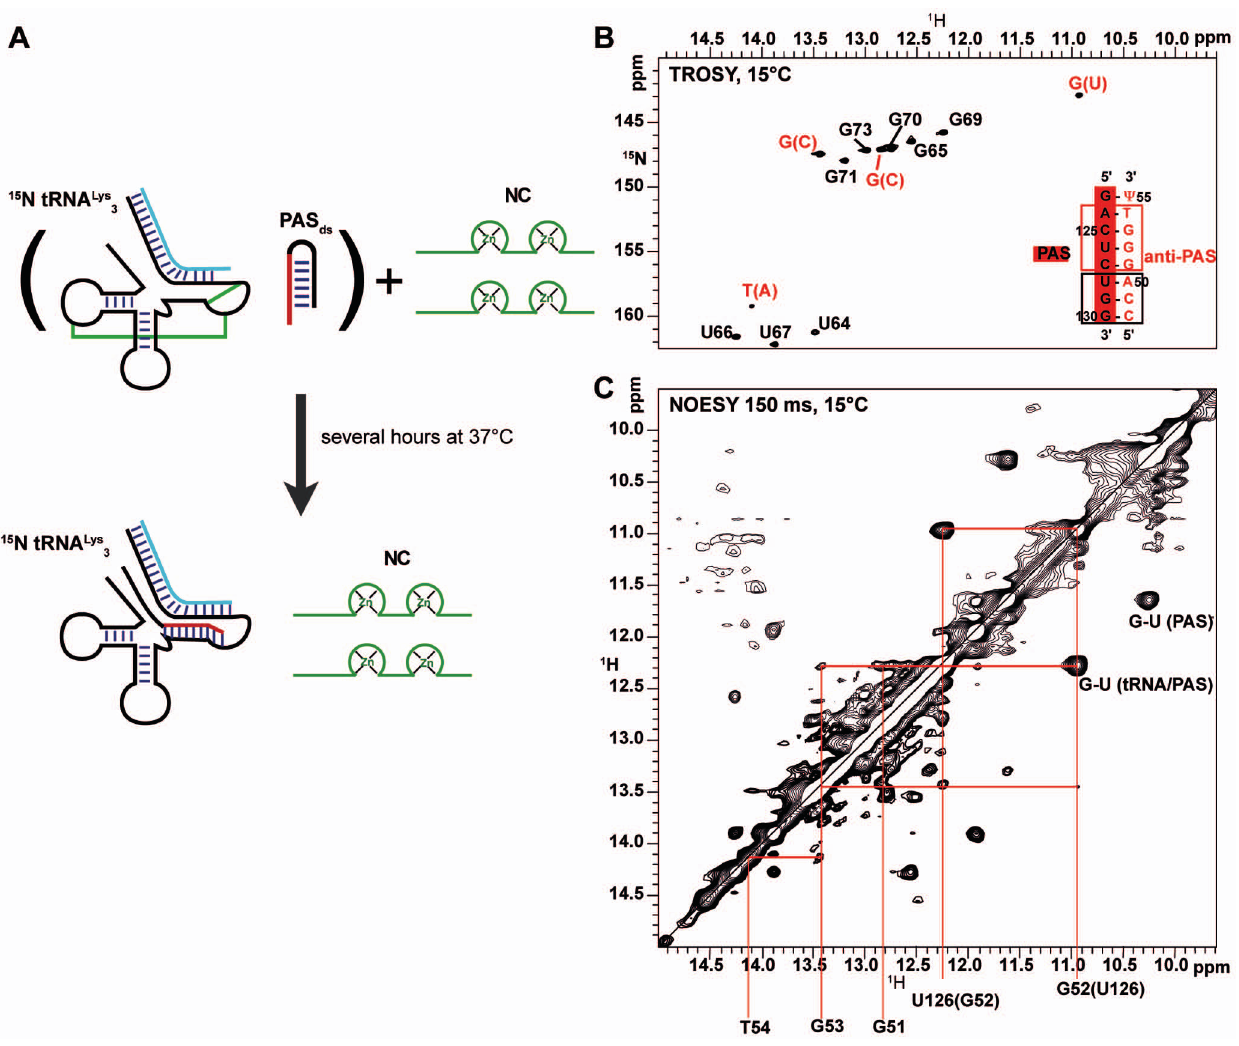
Figure 7. Assignment of the NCp7-mediated tRNA Lys 3 /PBS/PAS ds complex (0.5 mM of each component). A) Schematic drawing of the experimental procedure, B) TROSY experiment recorded at 15 u C showing the imino groups of tRNA Lys 3 (0.5 mM) after the NCp7-mediated procedure described in A), C) NOESY experiment recorded on the same sample as in A at 15 u C with a mixing time of 150 ms showing the region of the imino groups. The red square indicates base-pairings assigned thanks to the use of the TROSY (A) and the NOESY (B) experiments whereas the black square indicates base-pairings assigned from the comparison of NOESY experiments.